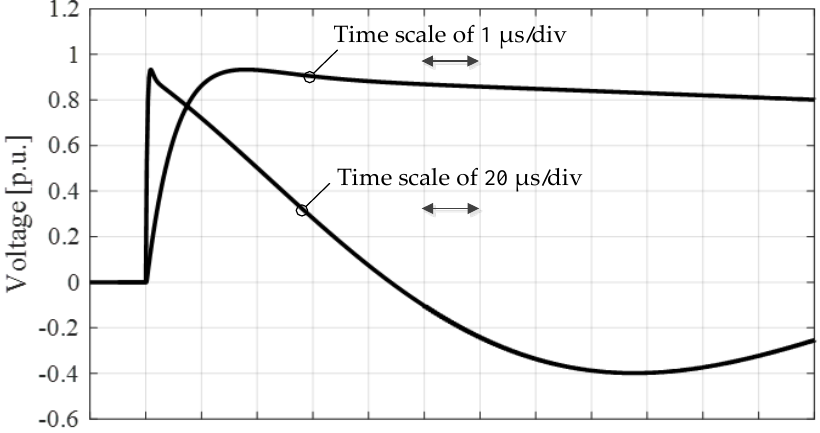
Figure 10. Generated waveform of Case 5 in Table 4 and by the proposed approach.